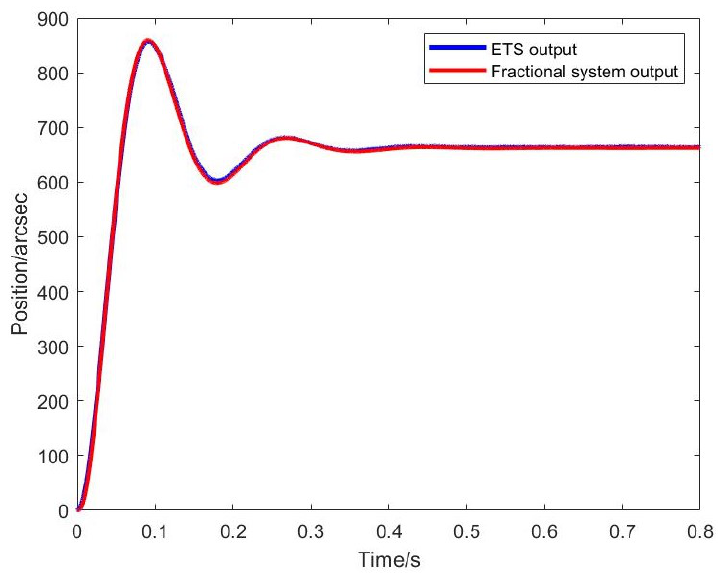
Figure 5. Fractional order system fitting.